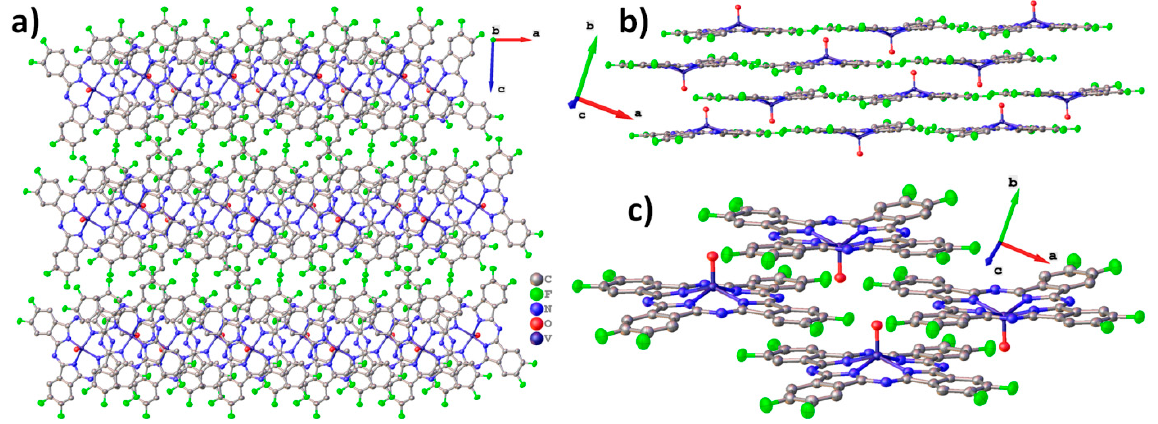
Figure 3. Molecular packing diagrams for VOPcF 8 : the packing motif along the a axis ( a ), the arrangement of molecules inside an individual layer ( b ), and a close-up view of the arrangement of neighboring molecules inside the layer ( c ).